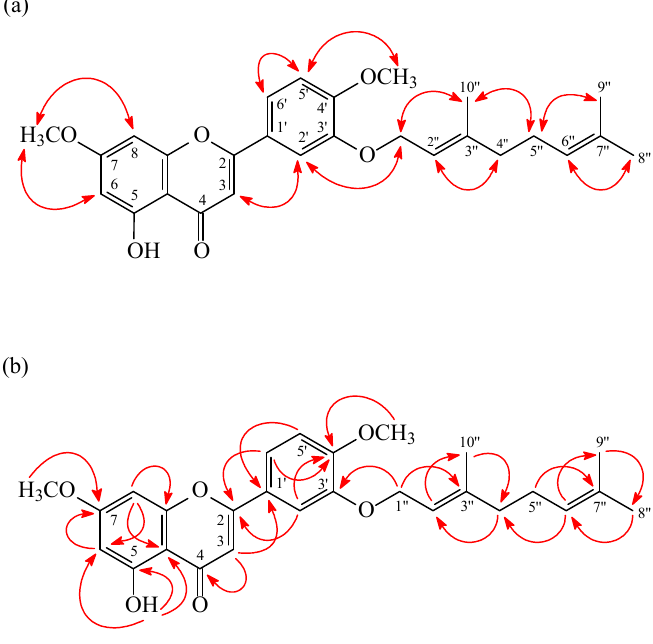
Figure 3. NOESY ( a ) and HMBC ( b ) correlations of 2 .